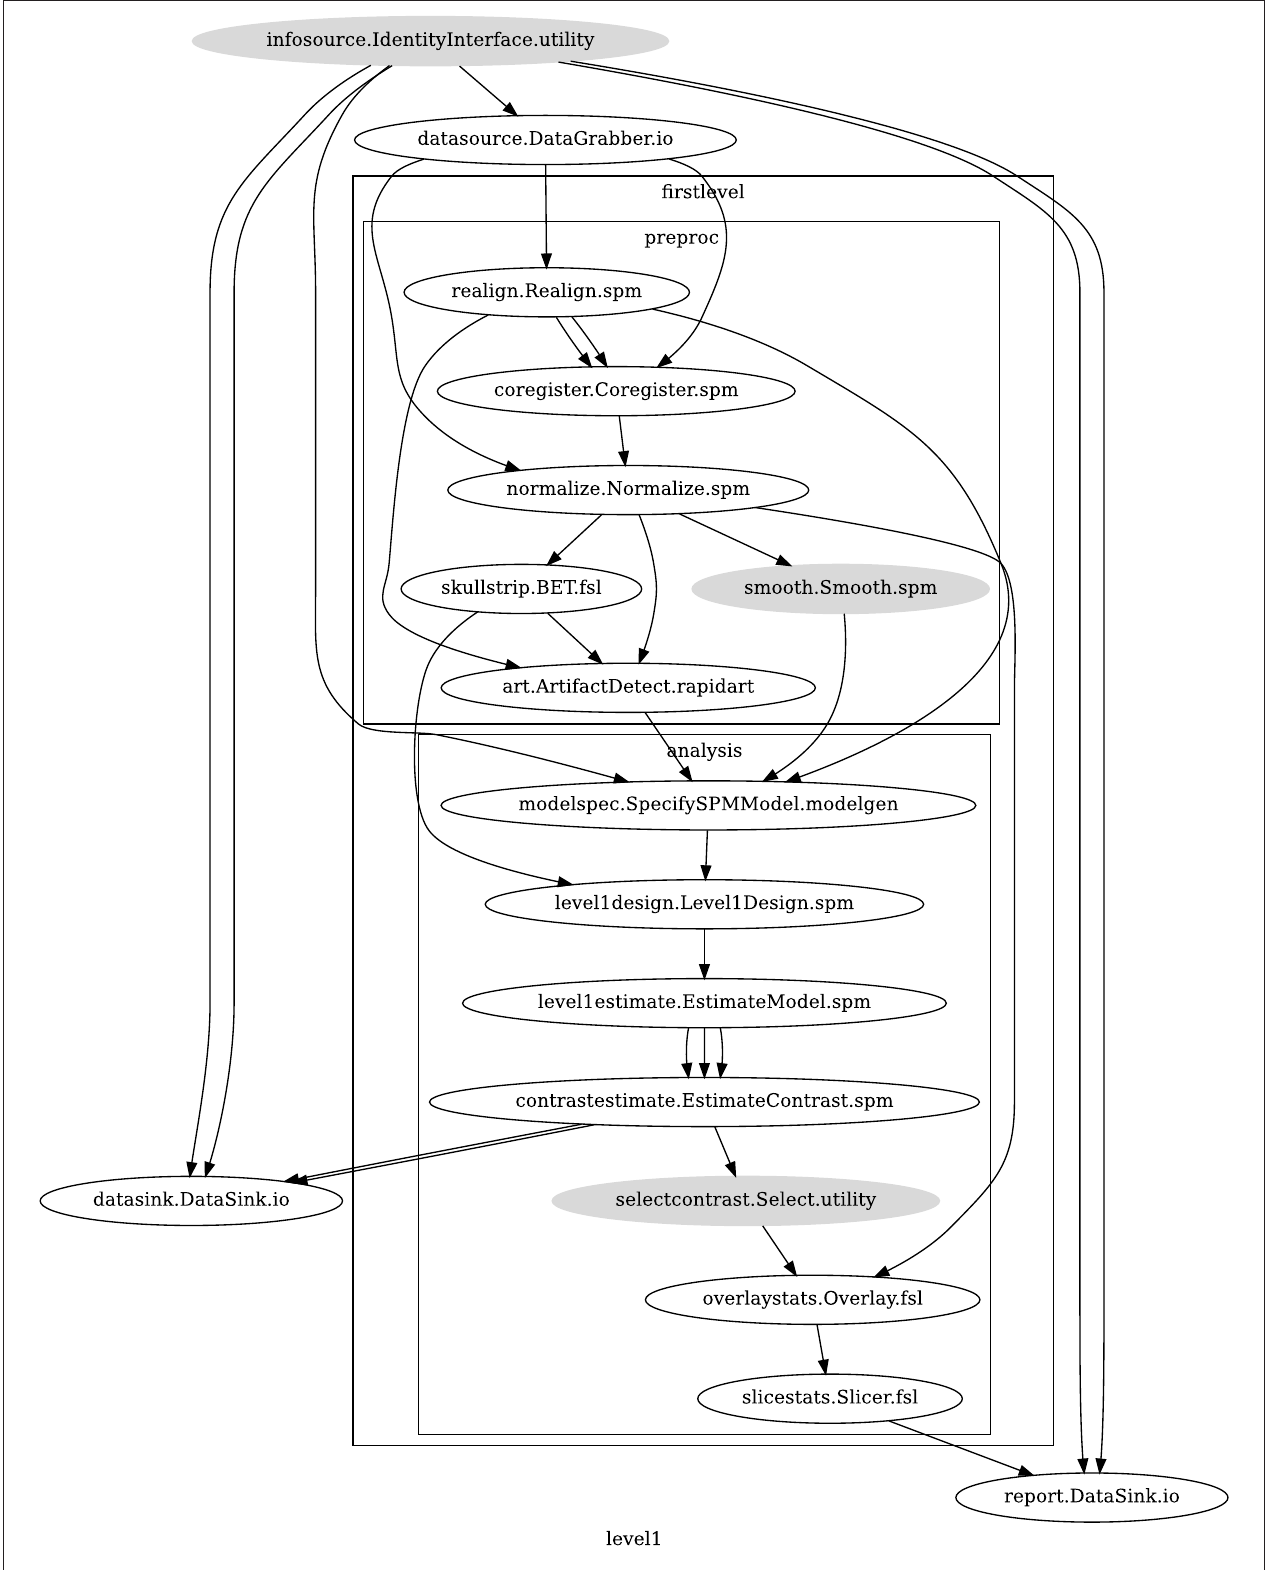
FiGure 9 | Single subject fMri Workflow used for benchmarking parallel